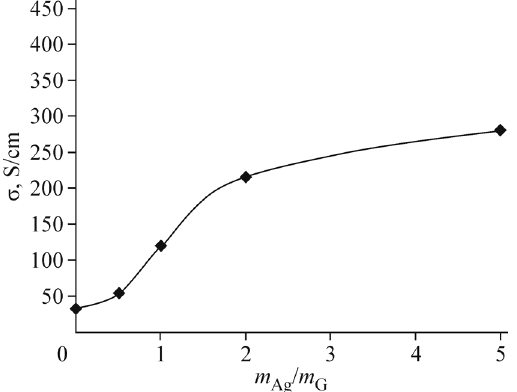
Figure 10. Conductivity of the insulated Ag/RGO composite electrode versus the silver/graphene ratio. Reproduced from [32] with permission from Springer Nature. Copyright 2018.